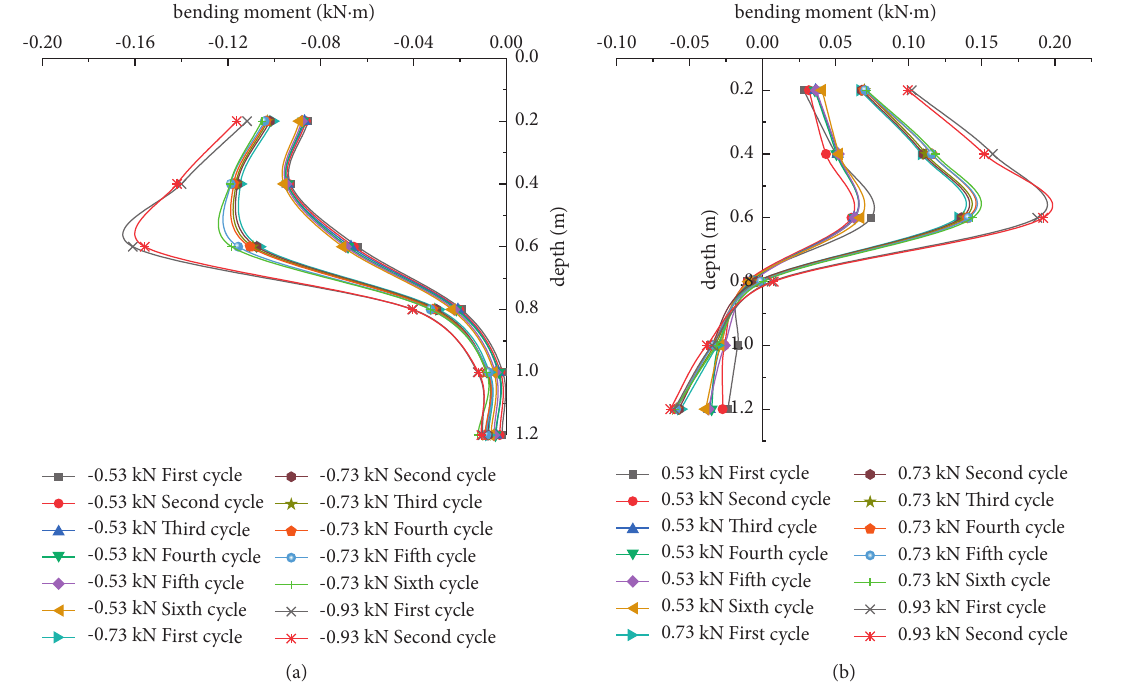
Figure 11: Bending moment distribution of LK3 under different load amplitude under reverse and forward loading. (a) In reverse loading process. (b) In forward loading process.